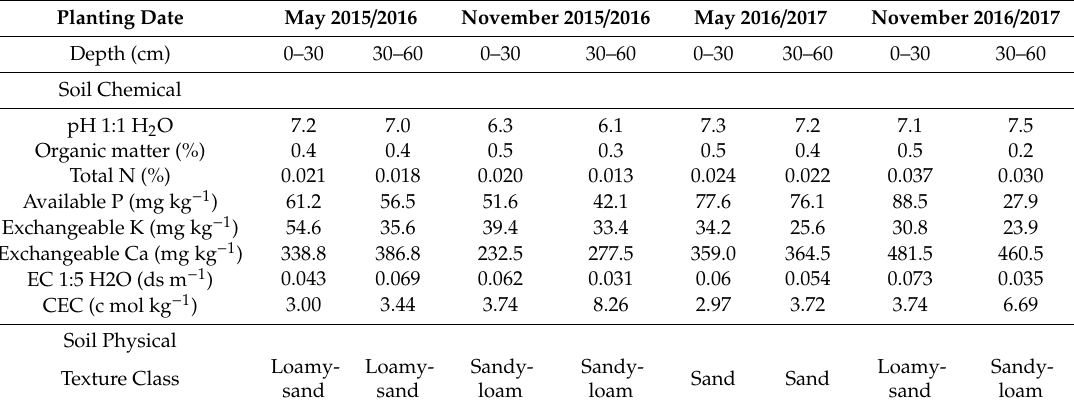
Table 1. Chemical and physical properties of the soil in the experimental fields at the depth 0–30 and 30–60 cm at planting date May and November 2015 and 2016.